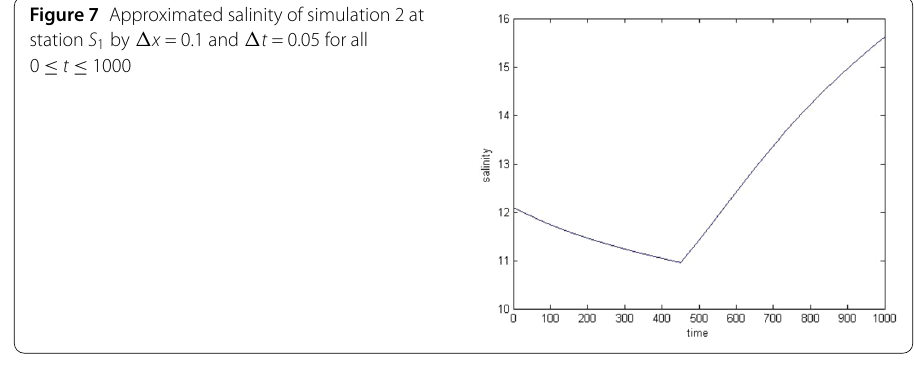
Figure 8 Approximated salinity of simulation at station S 5 by (cid:4) x = 0.1 and (cid:4) t = 0.05 for all 0 ≤ t ≤